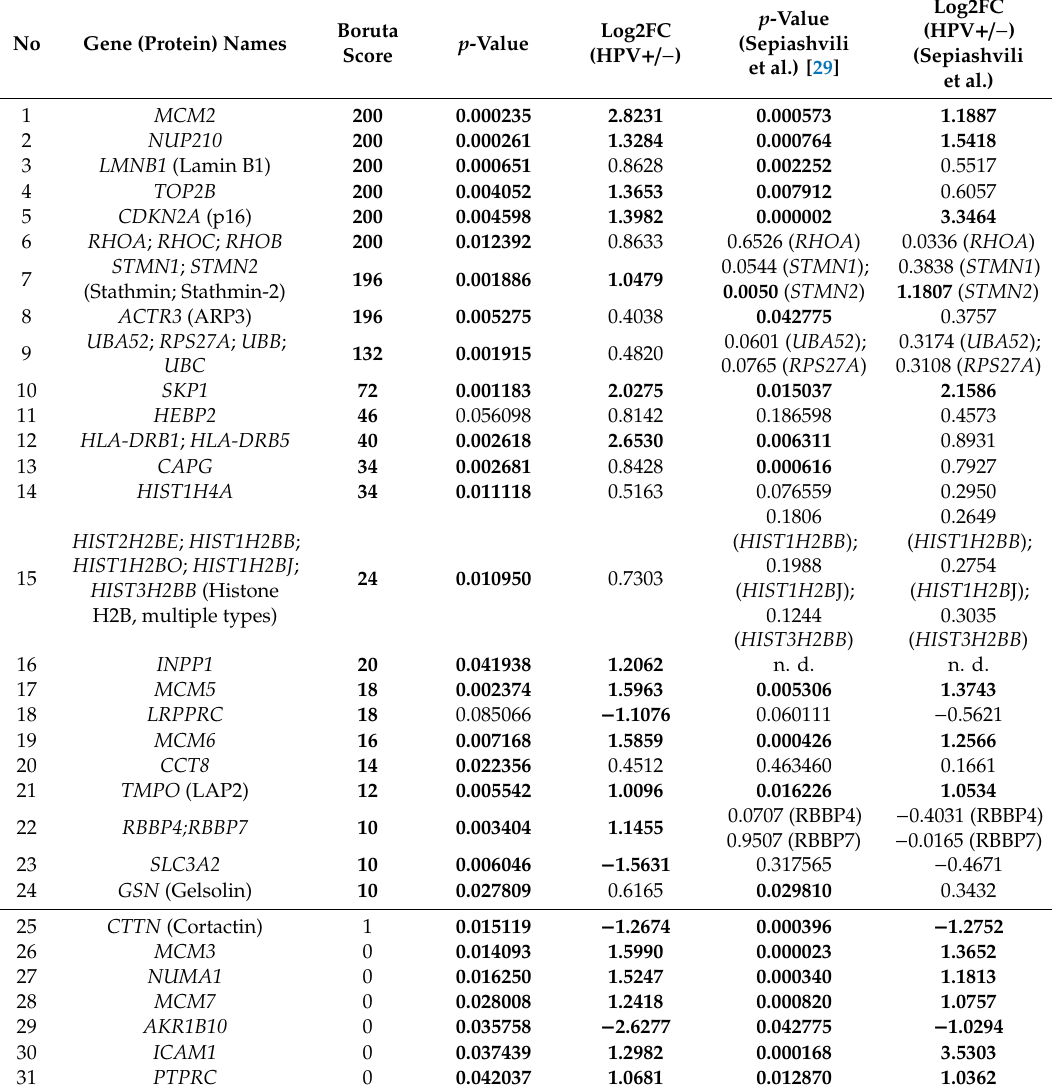
Table2. Proteinsdi ff erentiallyexpressedinHPV-positiveandHPV-negativeHNSCC.Proteins1–24were identified as unequally expressed through the random forest analysis, proteins 25–31 were additionally identified through significance (unadjusted) and fold change (di ff erence ≥ 2 fold, corresponding to Log2FC values ≥ 1 or ≤− 1) congruently in this and a comparable previous study [29]. Bold numbers indicate that the respective thresholds were